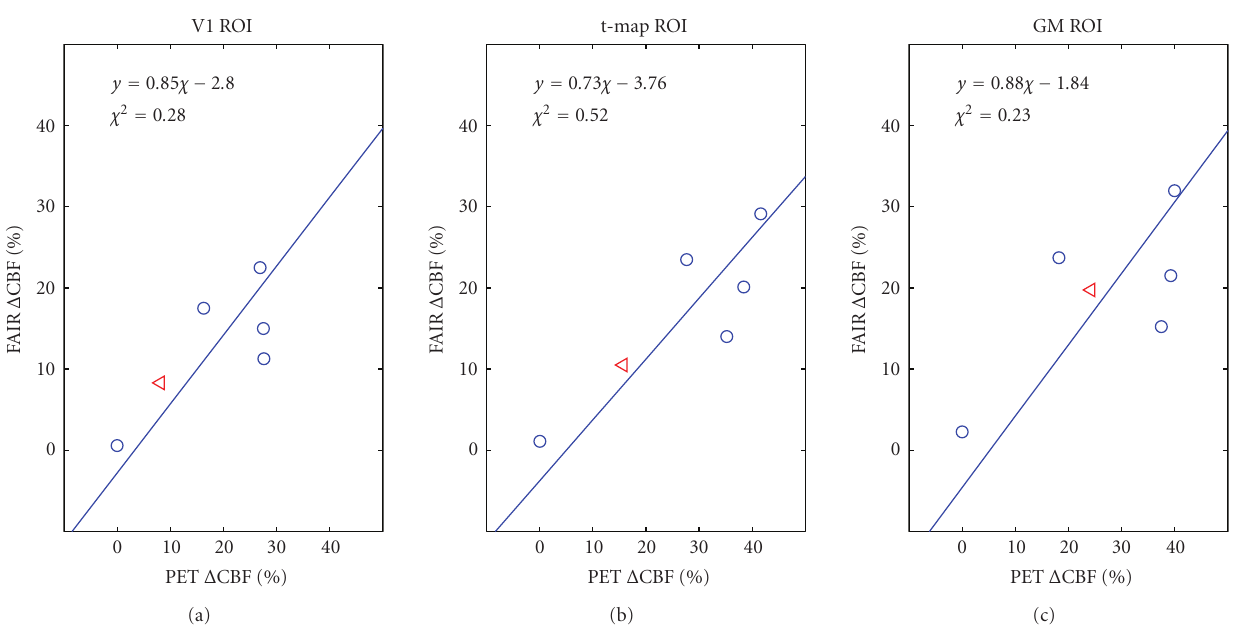
Figure 6: Correlation plots of group-average fMRI CBF percent changes with respect to PET CBF changes in the V1, t -map, and GM ROIs. The dots represent results from baseline and 4 levels of visual stimulation, and the triangles represent the results for the 5% hypercapnia condition. The equations resulted from the linear fitting of the data, represented by the dotted lines. The hypercapnic Δ CBF measured using PET and MR are similar. In all 3 cases, the χ 2 values have probabilities well within the range of acceptance, and t -test results indicate the slope of the linear fit is not significantly di ff erent from